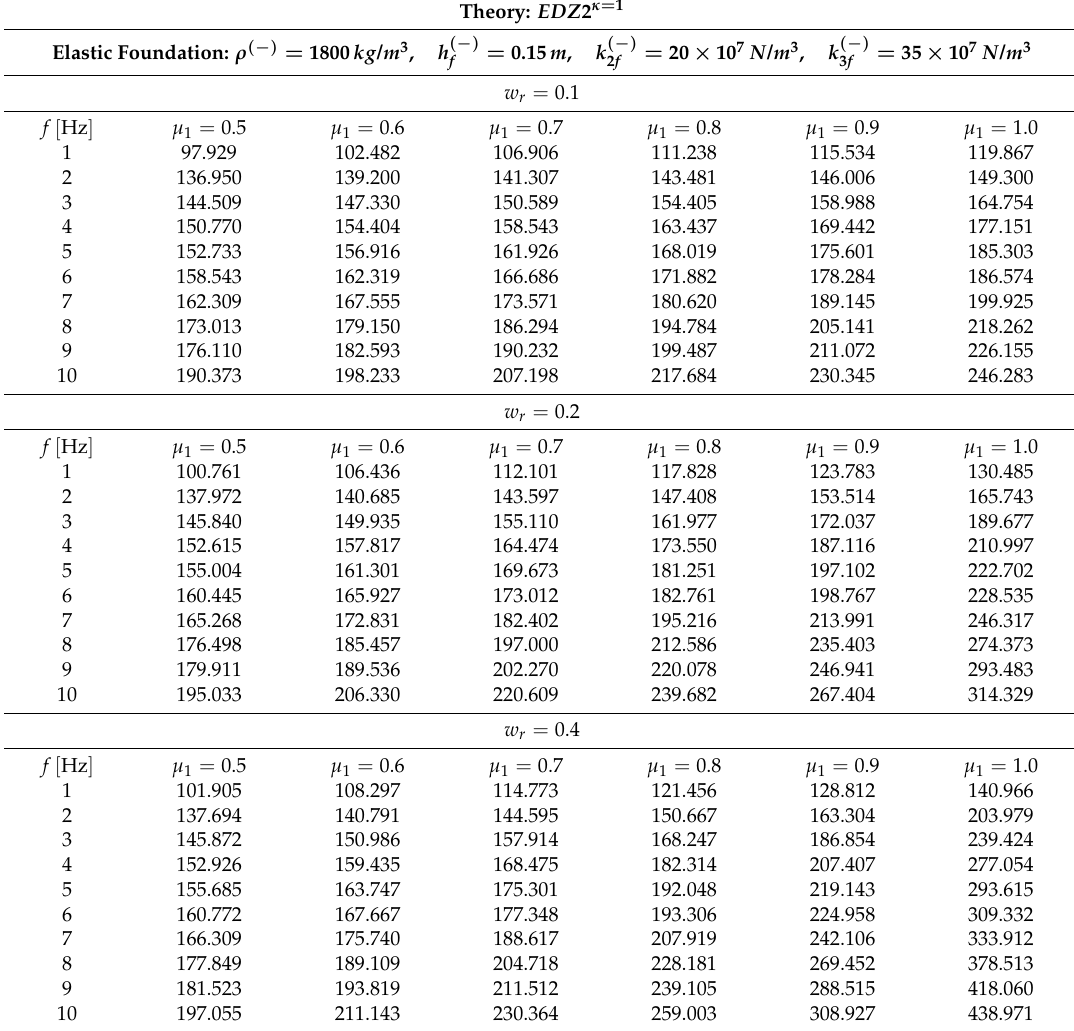
Table 12. First ten natural frequency variations for EDZ2 κ = 1 theory of a CCFF helicoidal surface (Figure 4c) reinforced by CNTs distributed as in Figure 5c for different mass fractions w r when varying the parameter of agglomeration µ 1 with µ 2 = 1. The Chebyshev-Gauss-Lobatto grid distribution was employed, with I N = 31, I M =